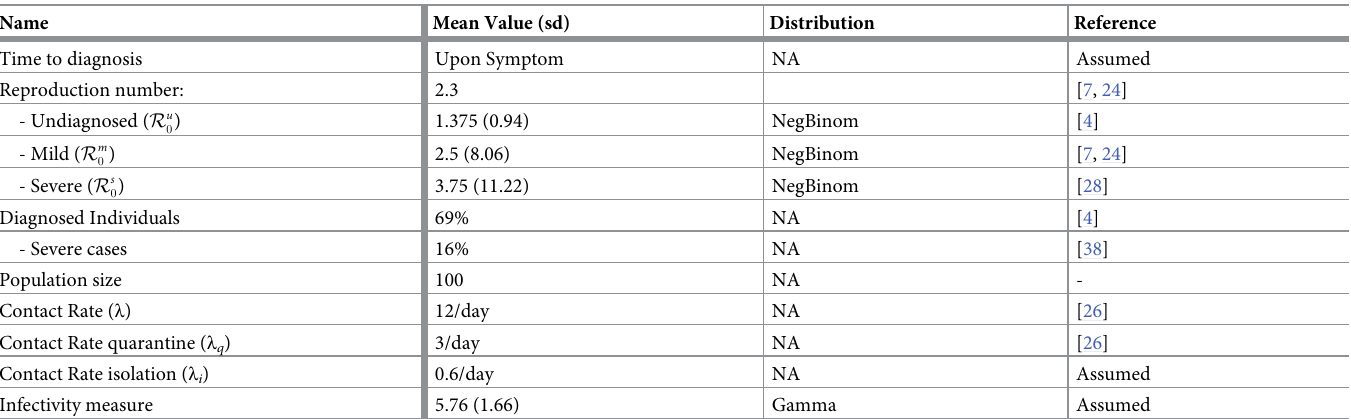
Table 1. Model parameters—Baseline